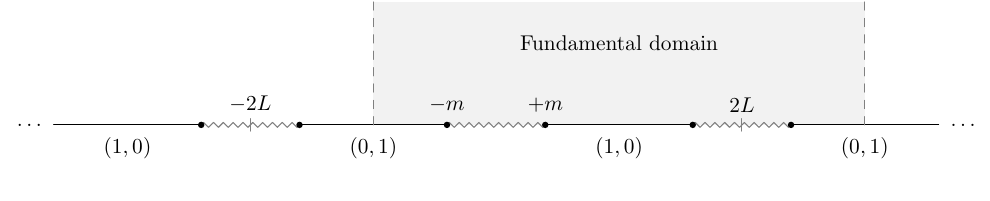
Figure 6 . Rod structure for Example